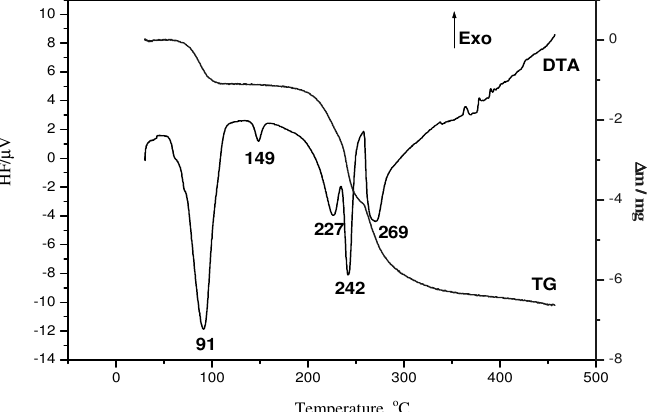
Figure 3. DTA and TG curves of (C